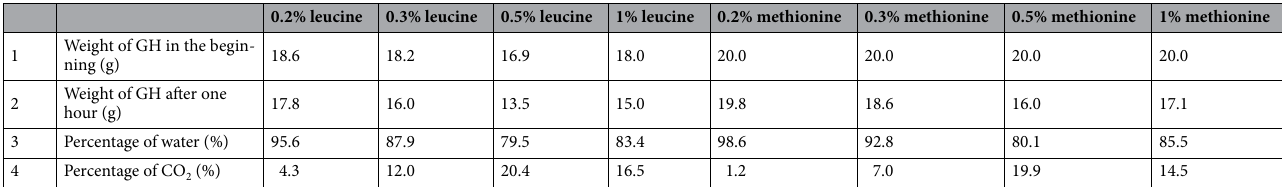
Table 2. Effect of increasing amount of amino acids to percentage of CO 2 present in